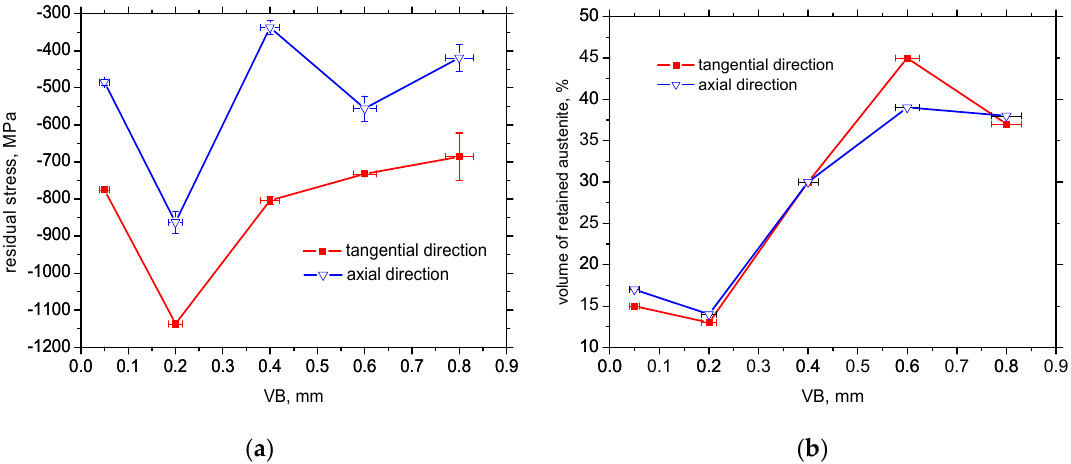
Figure 11. Evolution of residual stresses and retained austenite volume with VB (volume of retained austenite after HT 19%): ( a ) evolution of residual stresses, and ( b ) evolution of retained austenite volume.